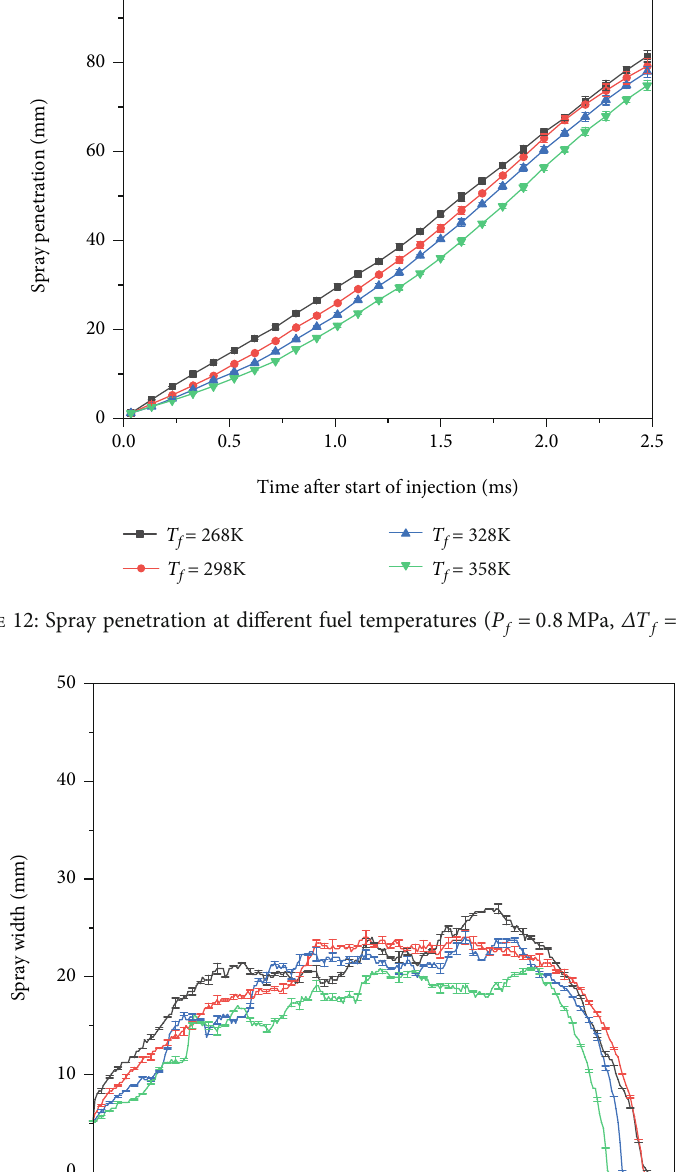
Figure 13: Spray width at di ff erent axial positions at di ff erent fuel temperatures ( t = 2 : 5ms , P